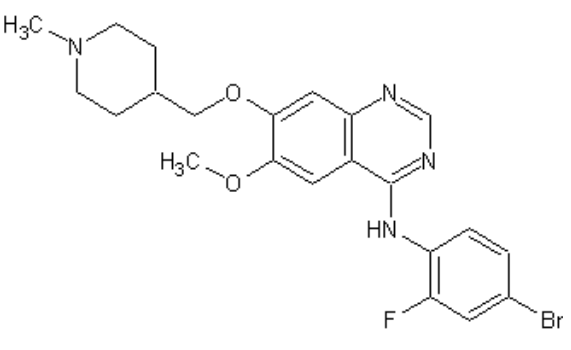
Figure 1. Structure of vandetanib.